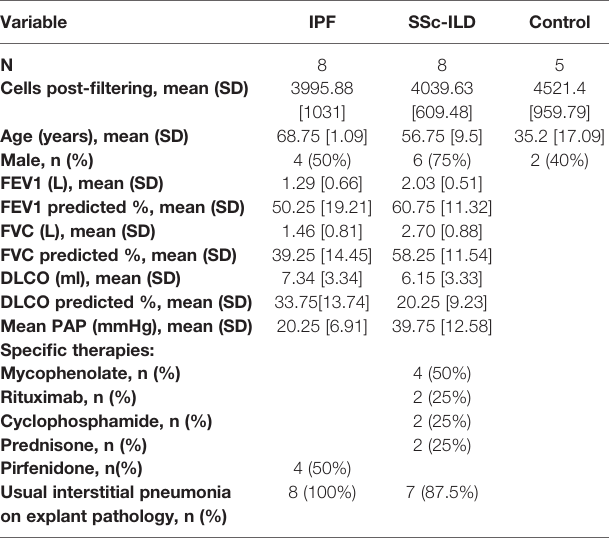
TABLE 1 | Characteristics of Patient Samples Demographics, the number of cells analyzed after fi ltering in the scRNA-seq analysis, pathological review of adjacent tissue, and clinical characteristics of the patient samples